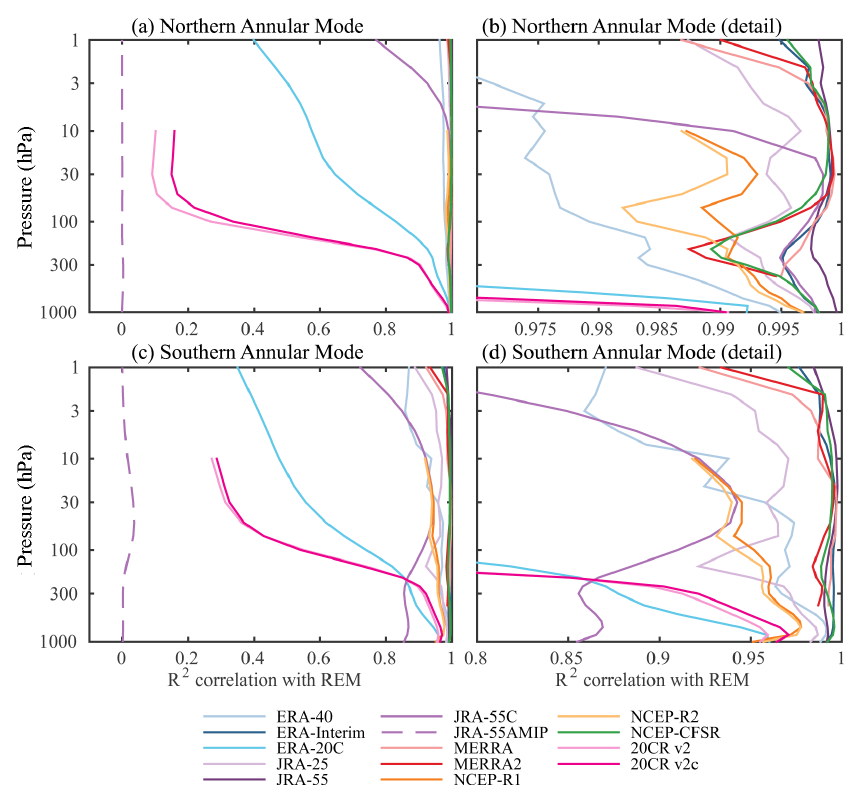
Figure 6. The squared correlation between the (a, b) Northern and (c, d) Southern Annular Mode indices computed from each individual reanalysis with the reanalysis ensemble mean (REM). We use the standard WMO 3-decade climatological period, 1981–2010, for all re- analyses except ERA-40, where analysis is based on 1981–2001. Panels (b, d) show the same data, but are enlarged to highlight the more accurate reanalyses. Note the difference in the range of the abscissa: the NAM is very well constrained in all reanalyses that assimilate free atmospheric